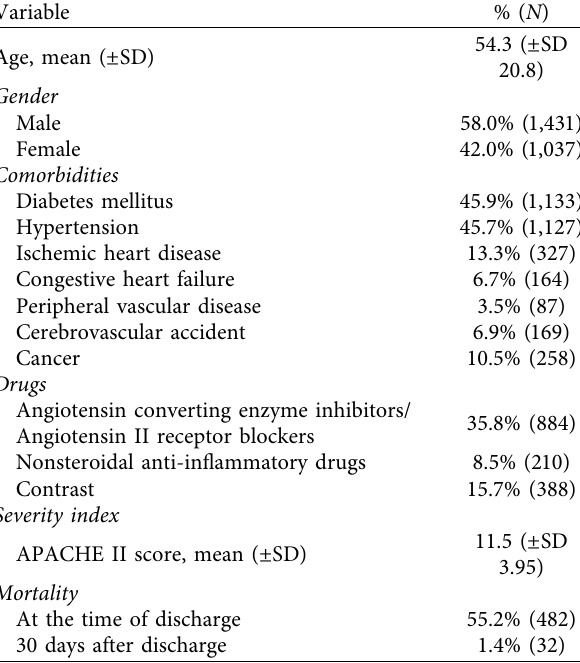
Table 1: Baseline characteristics.